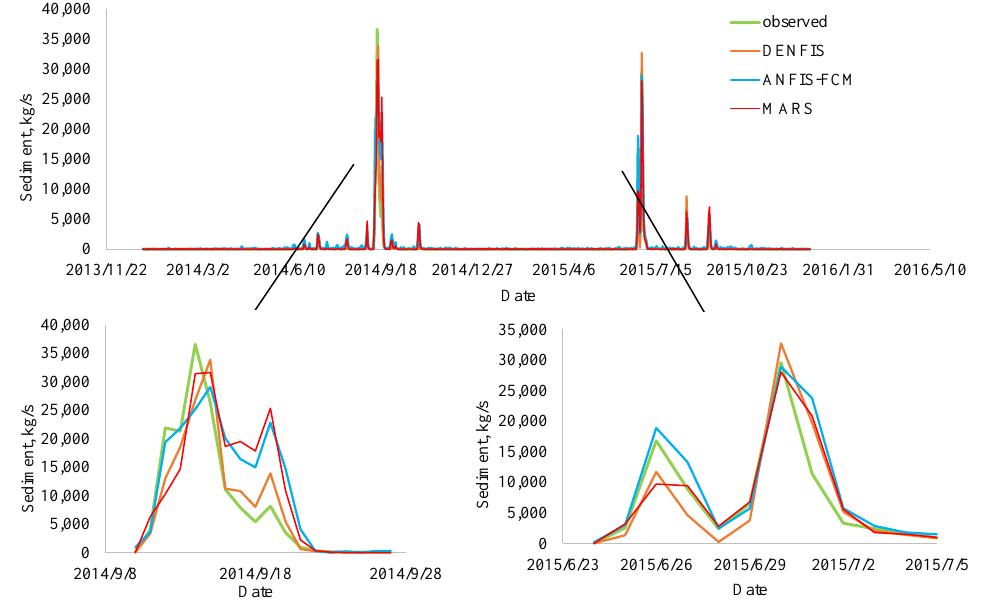
Figure 7. Time variation graphs of the observed and estimated suspended sediment by DENFIS, ANFIS-FCM and MARS in the test period at Beibei Station.